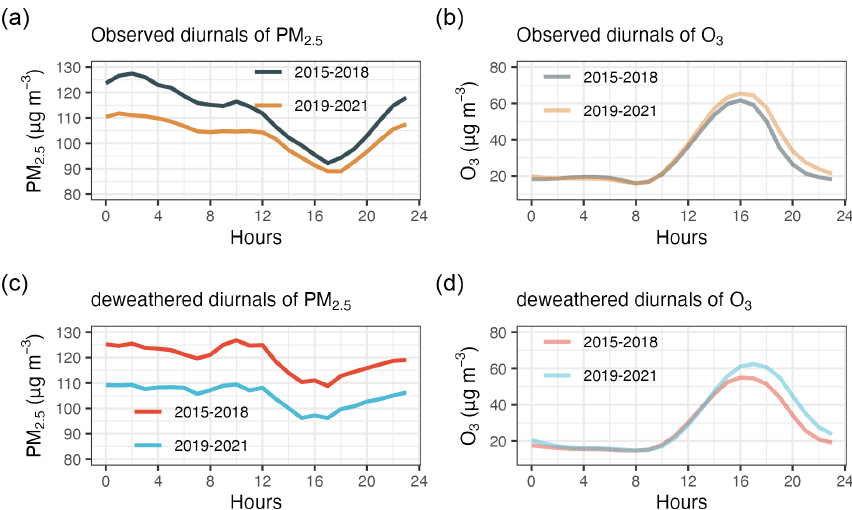
Figure 2. Observed and deweathered diurnal patterns for PM 2 . 5 (a,c) and O 3 (b, d) for January–February in 2015–2018 and 2019–2021. Table 1. Top 10 volatile organic compounds (VOCs)/oxygenated VOCs (OVOCs) and the ozone formation potential (OFP). Formula Exact mass Assignment Mean (ppb)